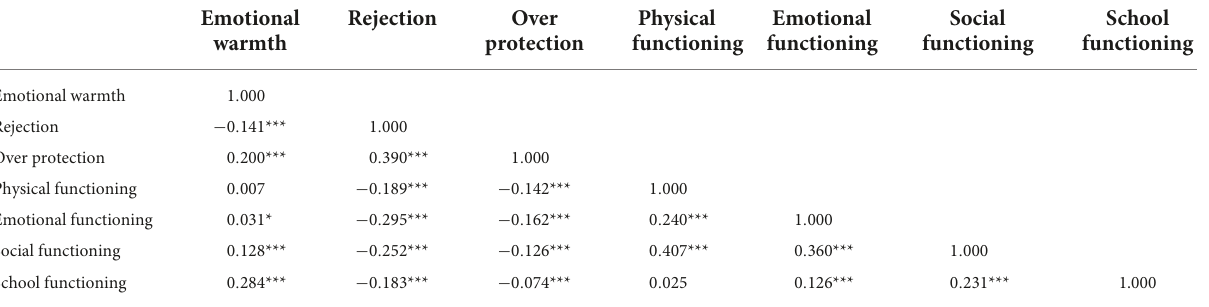
TABLE 2 Correlation matrix between children’s HRQOL and maternal parenting